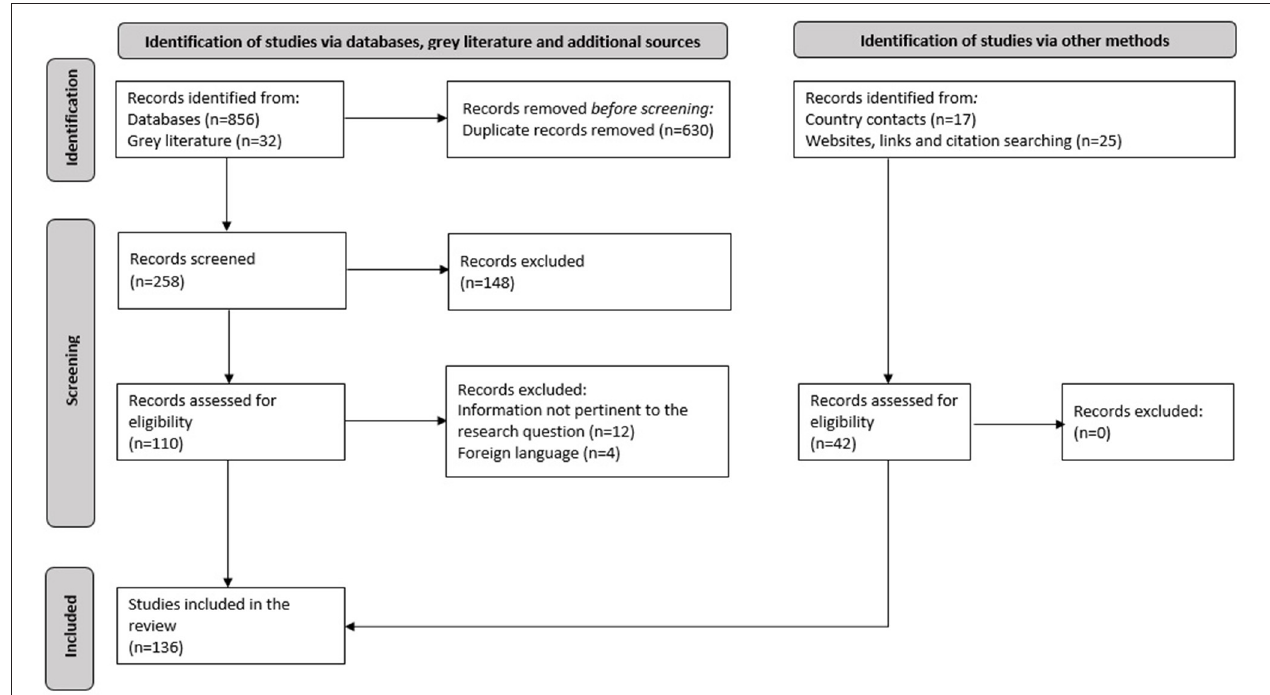
FIGURE 1 | Search and identification process of potential references from the literature.